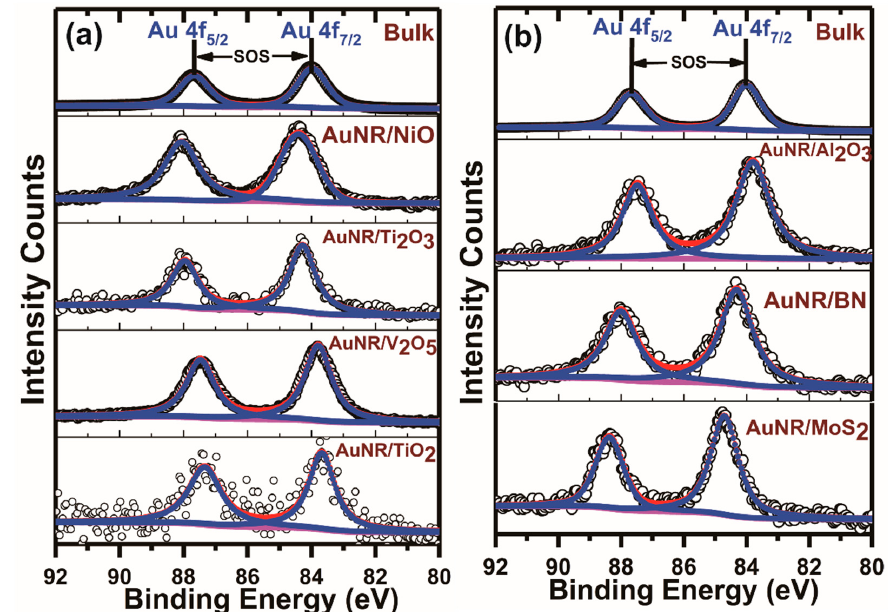
Figure 4. Fitted high-resolution X-ray Photoelectron Spectroscopic (XPS) Au4f spectra from the as-synthesized supported AuNRs on different materials: ( a ) NiO, Ti 2 O 3 , V 2 O 5 , TiO 2 , and ( b ) Al 2 O 3 , BN, MoS 2 respectively. Au 4f spectra from two bulk gold samples are also shown for comparison purposes. The C 1s peak from adventitious carbon was selected as the reference peak and was used as a calibration standard for these supported nanoparticles. The spin-orbit-splitting (SOS) values were calculated from the separation between the two core level excitation peaks, Au 4f 7/2 and Au 4f 5/2 , respectively. Contrary to the standard bulk reference values, the Au 4f 7/2 peaks showed both upshifts and downshifts in presence of the support